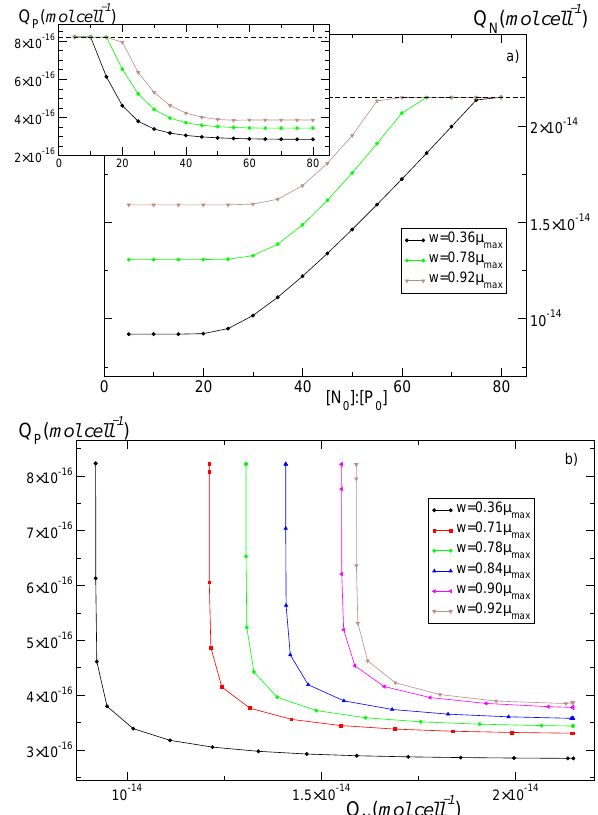
Fig. 5. Variation of N quota (main panel in (a) ) and P quota (inset in panel (a) ) with the supply ratio for different values of the dilution rate. Effective maximum quota values are shown as dashed lines. (b) Phosphorus quota versus nitrogen quota for different dilution rates; single-limitation zones show constant values for the quota of the limiting nutrient.